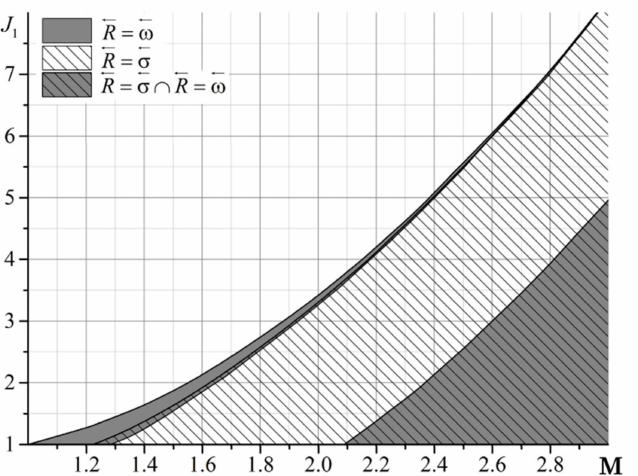
Figure 11. Domains of existence of different types of reflected discontinuity depending on Mach number M and the intensity of the first shock, J 1 , γ =